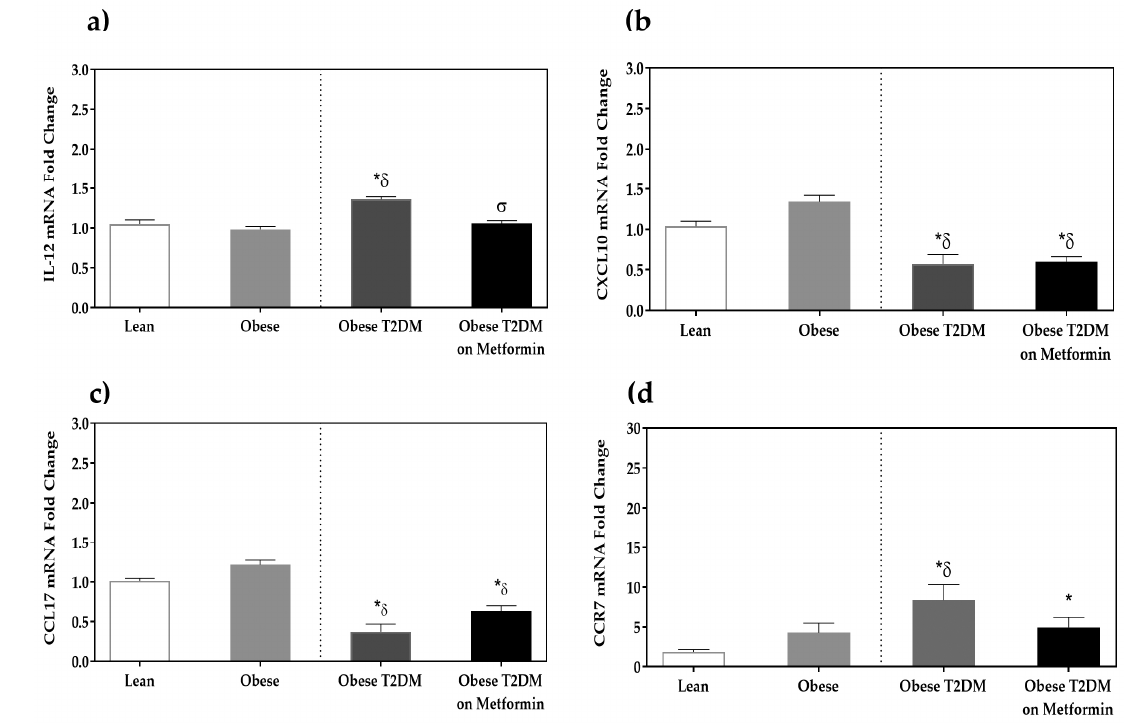
Figure 2. mRNA expression of macrophage markers in the peripheral blood mononuclear cells (PBMCs) of lean, obese, obese T2DM, and obese T2DM on Metformin groups: ( a ) IL-12; ( b ) CXCL10; ( c ) CCL17; and ( d ) CCR7. Results are presented as Mean ± SEM. One-way ANOVA on ranks, p < 0.001 for IL-12, CXCL10, CCL17, and CCR7, followed by Dunn’s test for pairwise comparisons and comparisons against normal-weight group, * p < 0.05 vs. normal-weight subjects; δ p < 0.05 vs. obese; σ p < 0.05 vs. T2DM subjects.